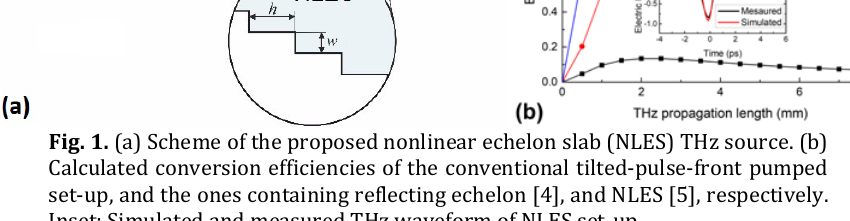
(a) Scheme of the proposed nonlinear echelon slab (NLES) THz source. (b) Calculated conversion efficiencies of the conventional tilted-pulse-front pumped set-up, and the ones containing reflecting echelon [4], and NLES [5], respectively. Inset: Simulated and measured THz waveform of NLES